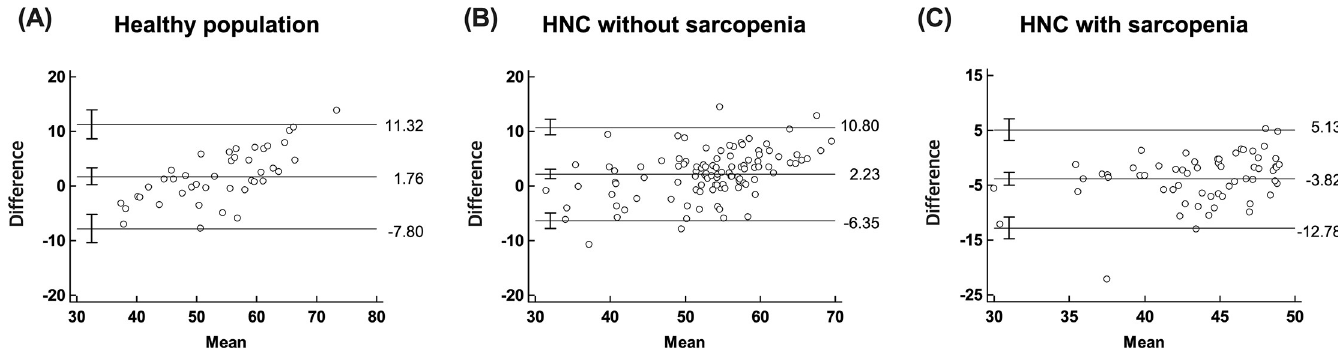
Fig 6. Bland-Altman plot showing the difference against the mean of actual and predicted L3 skeletal muscle indices in each group. Lines indicate the mean and the limits of agreement. HNC, head and neck cancer.